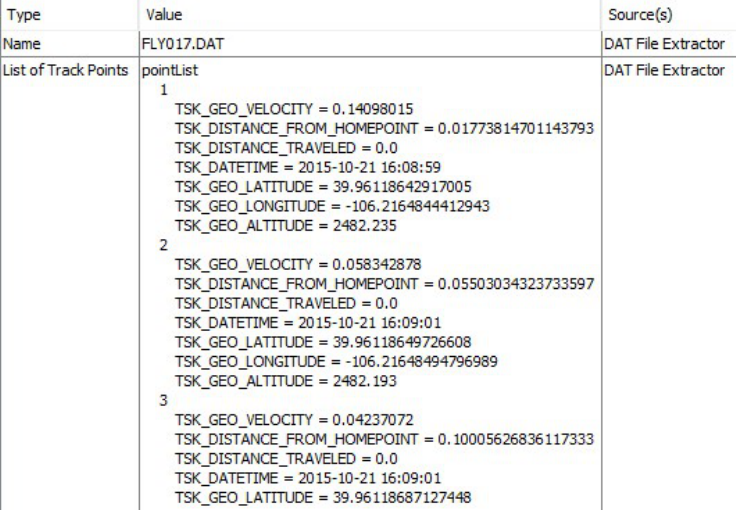
Figure 1. A .DAT file parsed by the Autopsy